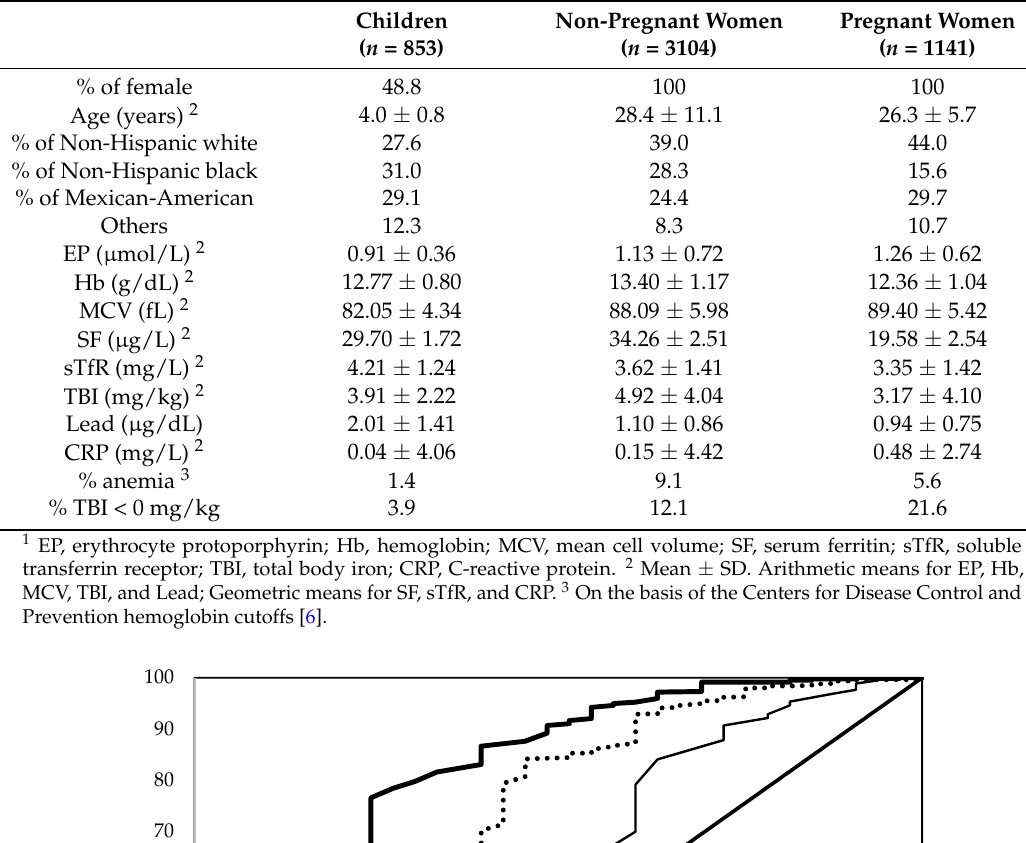
Table 1. Basic demographic and biochemical characteristics of the selected sample of children (three to five years old), non-pregnant women (15–49 years), and pregnant women from the National Health and Nutrition Examination Surveys (NHANES, 2003–2006 for children and non-pregnant women,